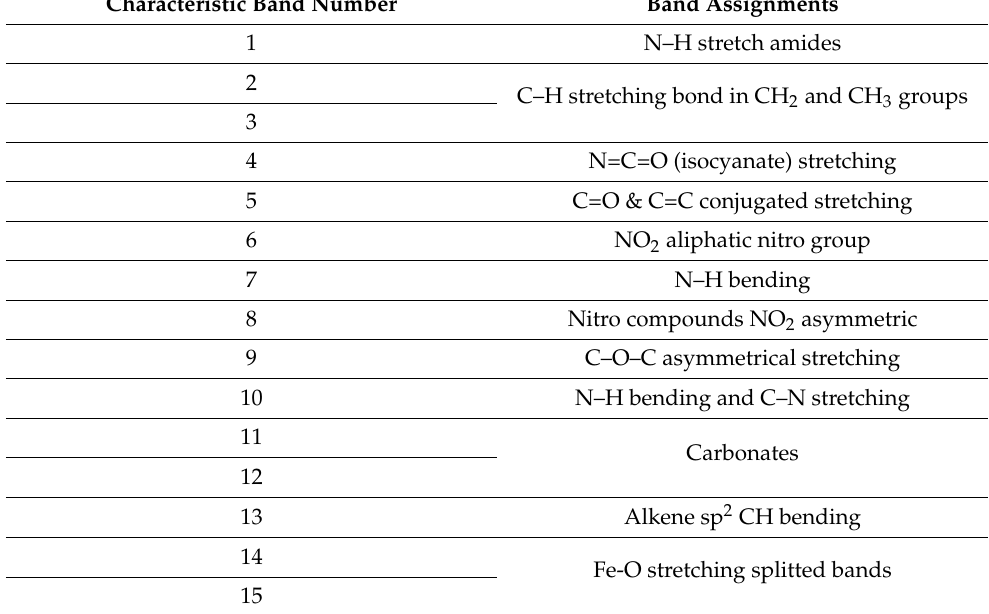
Table 1. Index of vibration modes of the FTIR spectra of polyurea, pure magnetite, and 3% magnetite- modified